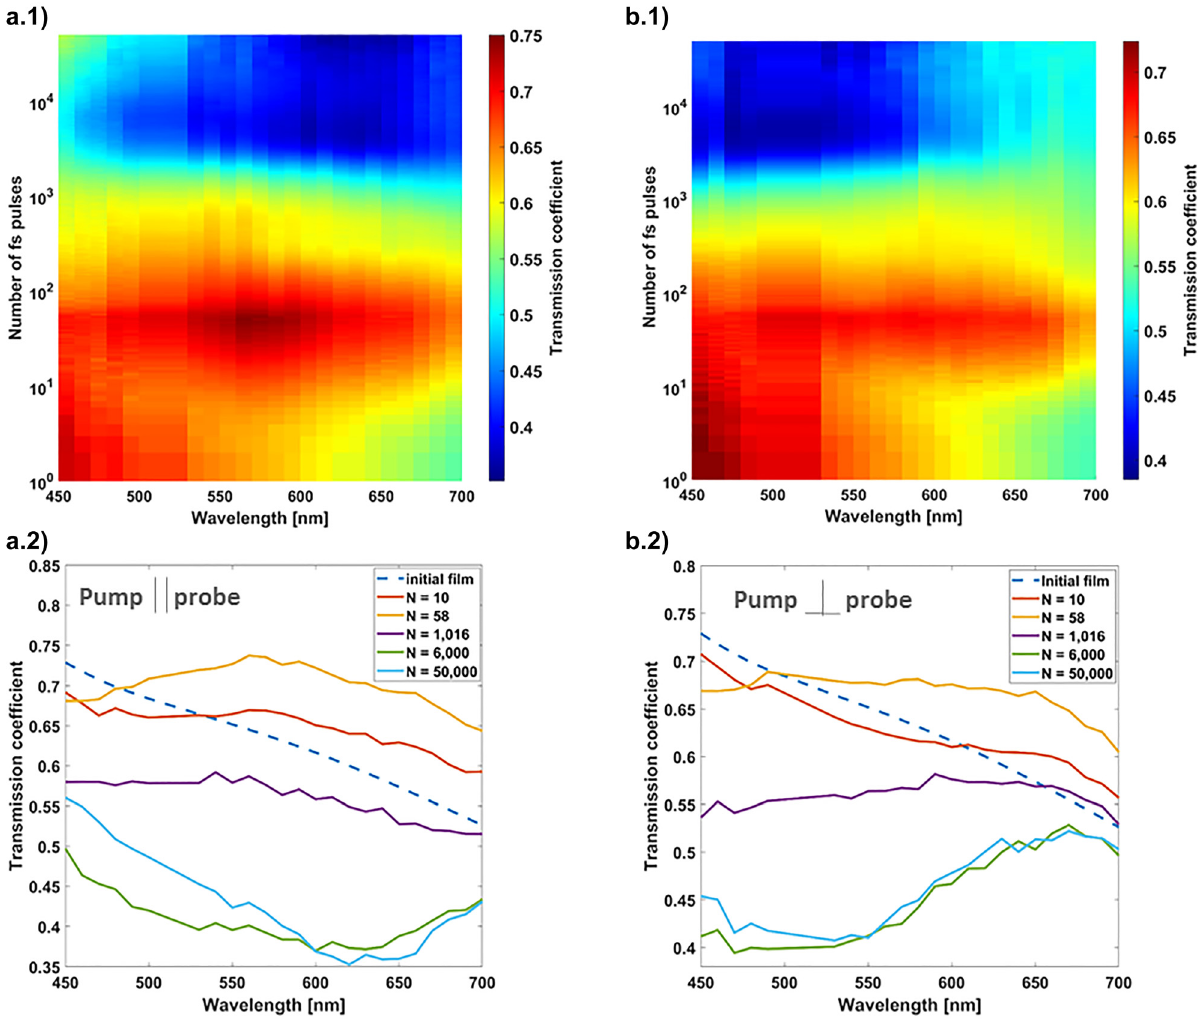
Figure 1: Pulse-to-pulse evolution of polarized transmissionspectra recorded in situ at the center of the fs-laser-processed area over the fi rst 50,000 pumplaser pulses.The laser fl uenceis 31 mJ/cm 2 . (a.1)and(b.1)2D plotsof thetransmissionspectraversus thefslaser pulsenumber N for a probe polarization parallel or perpendicular, respectively, to the pump laser polarization. A logarithmic scale is used for the pulse number. (a.2) and (b.2) Extracted spectra from (a.1) and (b.1) at characteristic pulse numbers N